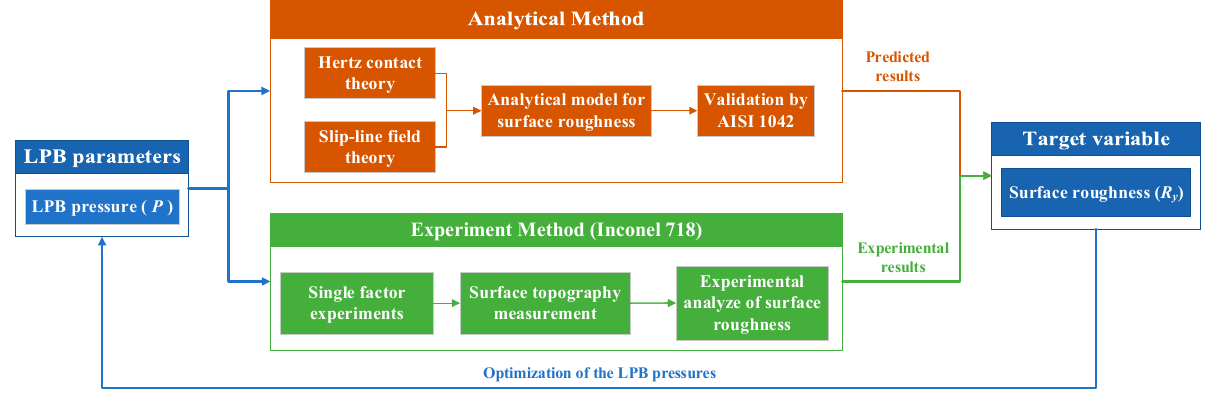
Figure 3. Analytical and experimental study framework.